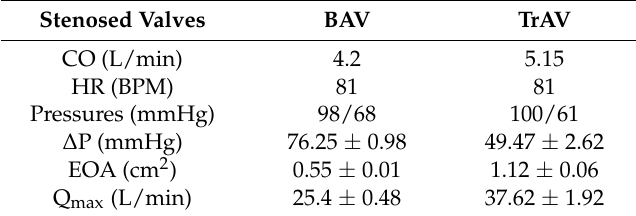
Table 1. Hemodynamic parameters of the representative native